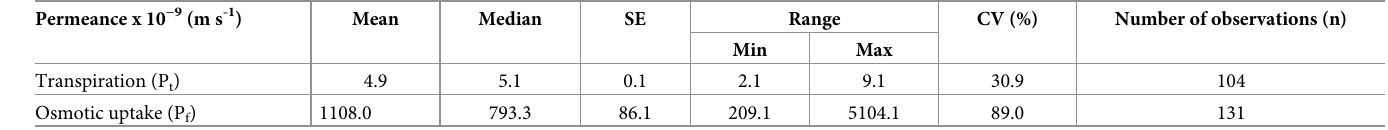
Table 2. Permeance for transpiration (P t ) and permeance for osmotic uptake (P f ) of the skins of ripe strawberry fruit cv.